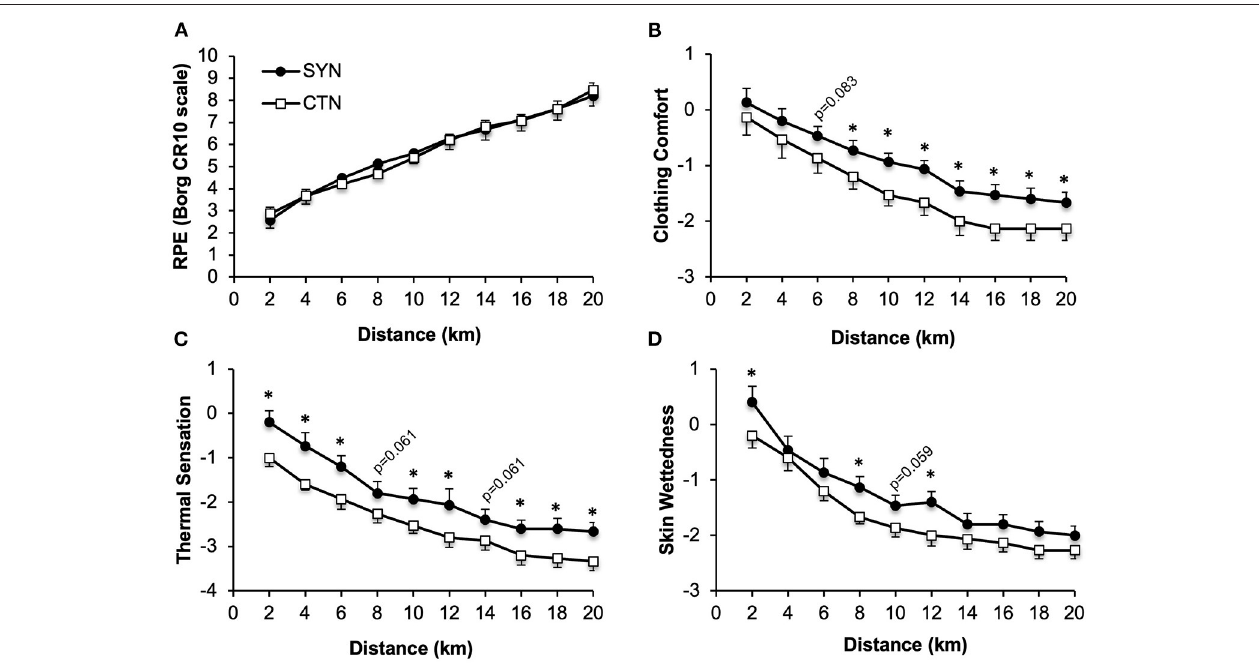
FIGURE 5 | Effect of wearing athletic clothing made of synthetic fabrics (SYN, 60% polyester: 40% nylon) and 100% cotton fabric (CTN) on perceptual responses during a 20-km cycling time trial in endurance-trained adults ( n = 15). Values are means ± SE. RPE, (A) rating of perceived exertion; CR10, 0-10 category ratio. (B) Participants rated clothing comfort using a 7-point scale ( + 3, very comfortable; + 2, comfortable; + 1, slightly comfortable; 0, neutral; − 1, slightly uncomfortable; − 2, uncomfortable; − 3, very uncomfortable); (C) thermal sensation using a 9-point scale ( − 4, very hot; − 3, hot; − 2, warm; − 1, slightly warm; 0, neutral; + 1, slightly cool; + 2, cool; + 3, cold; + 4, very cold); (D) skin wettedness using a 7-point scale ( − 3, too wet; − 2, wet; − 1, slightly wet; 0, neutral; + 1, slightly dry; + 2, dry; + 3, too dry). * p < 0.05 vs.